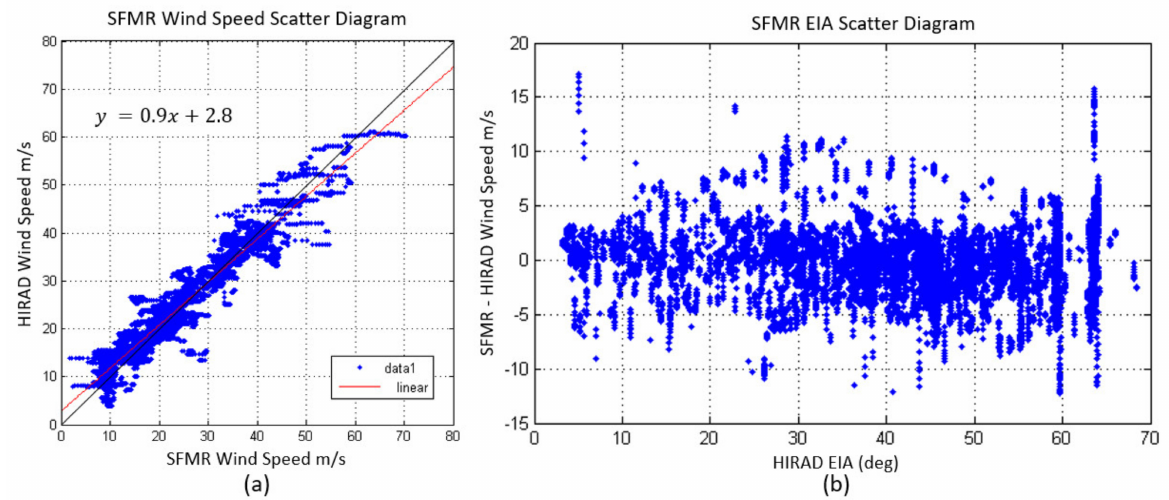
Figure 21. HIRAD comparisons with SFMR as a function of wind speed ( a ) and SFMR–HIRAD wind speed as a function of EIA ( b